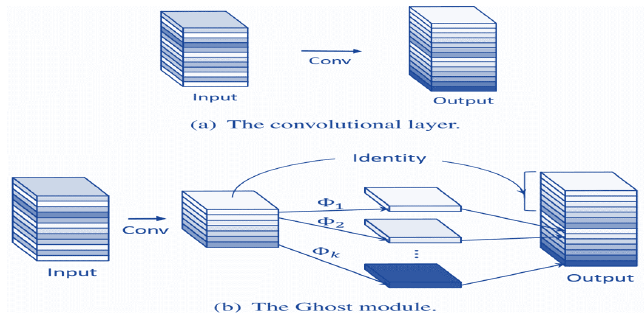
Figure 9. Architecture of Ghost.